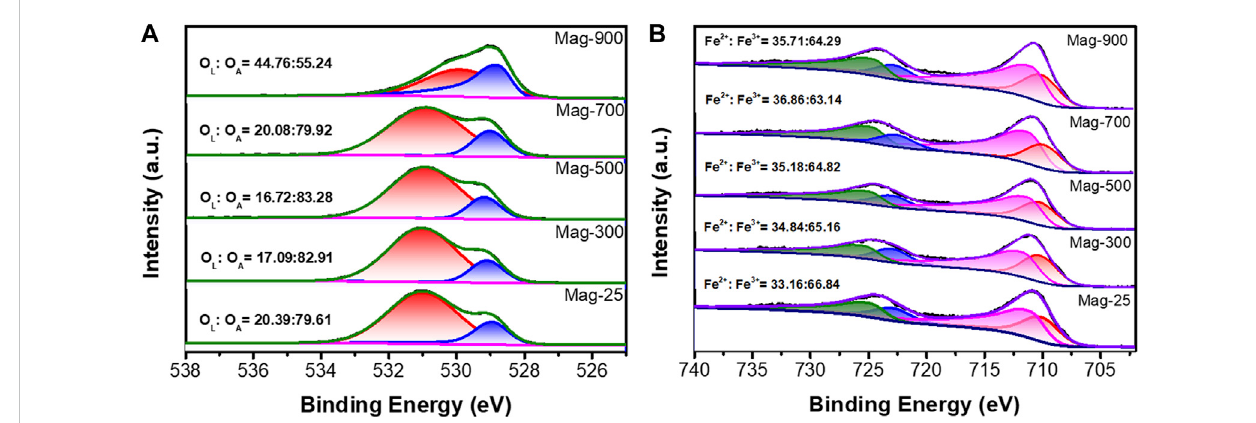
FIGURE 7 O 1s XPS spectra (A) and Fe 2p spectra (B) of magnetite at different temperatures.